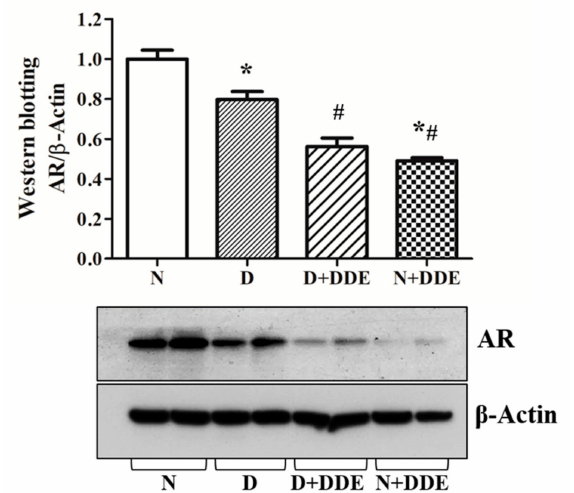
Figure 9. Analysis of androgen receptor (AR) protein levels were graphically represented as fold change vs. N. The data were calculated as media ± standard deviation. One-way ANOVA analysis showed significant di ff erences between treated and controls rats: * p < 0.05 vs. N; # p < 0.05 vs. D. Two-way ANOVA analysis indicated significant diet e ff ect, extremely significant DDE e ff ect, and extremely significant interaction (Bonferroni Post-hoc test: p < 0.001 D vs.